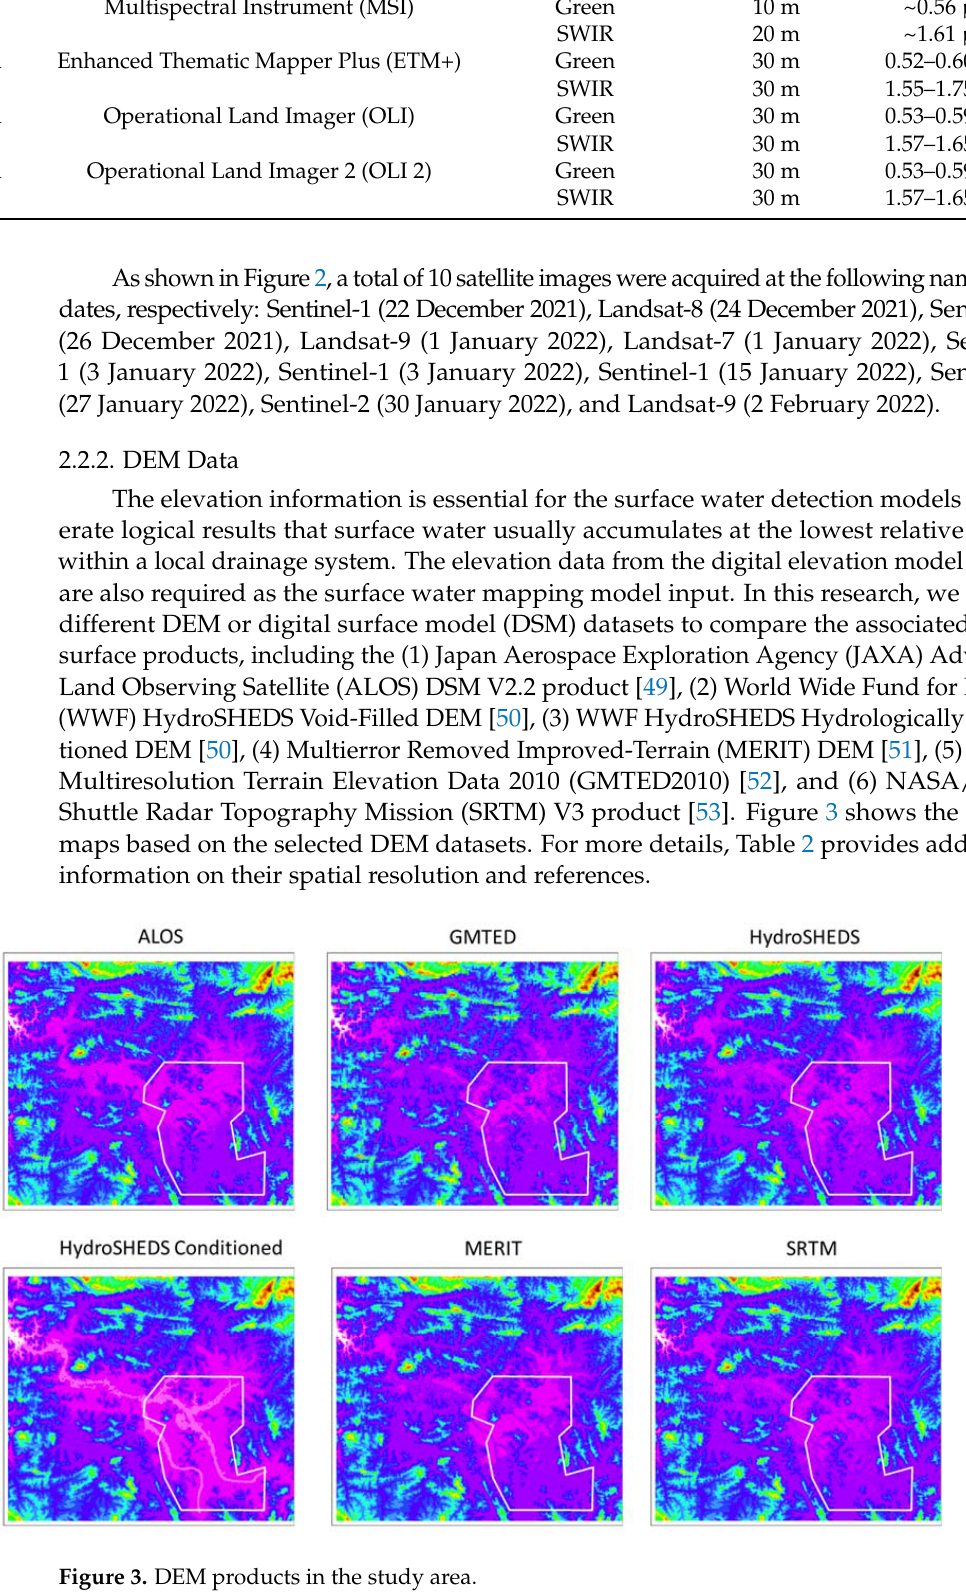
Figure 3. DEM products in the study area.